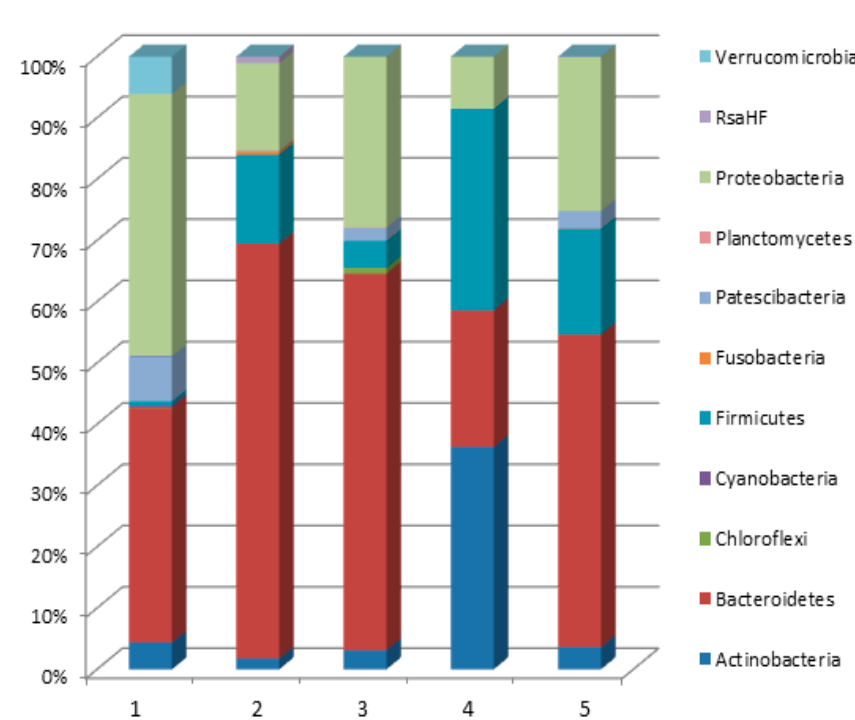
Figure 7. Taxonomic composition of microbial community of biofilms.